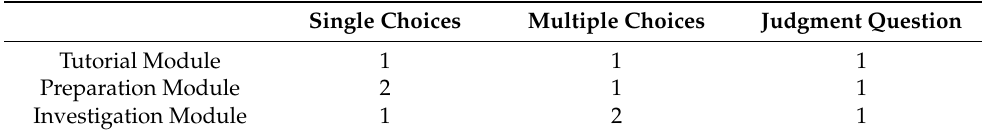
Table 3. Questionnaire Content